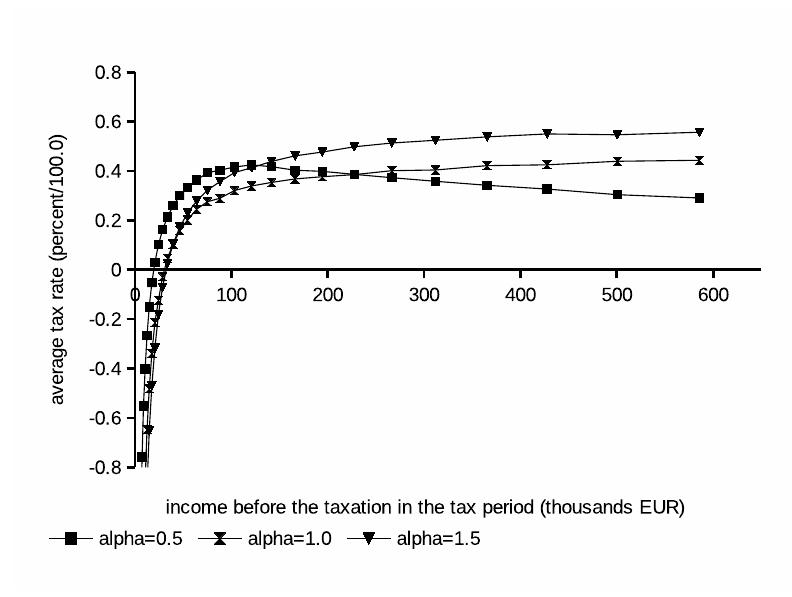
Figure 2. Redistribution curves for different α values.